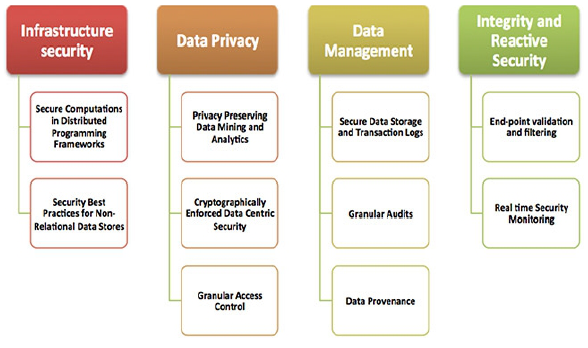
Figure 3. Data Security issues in cloud